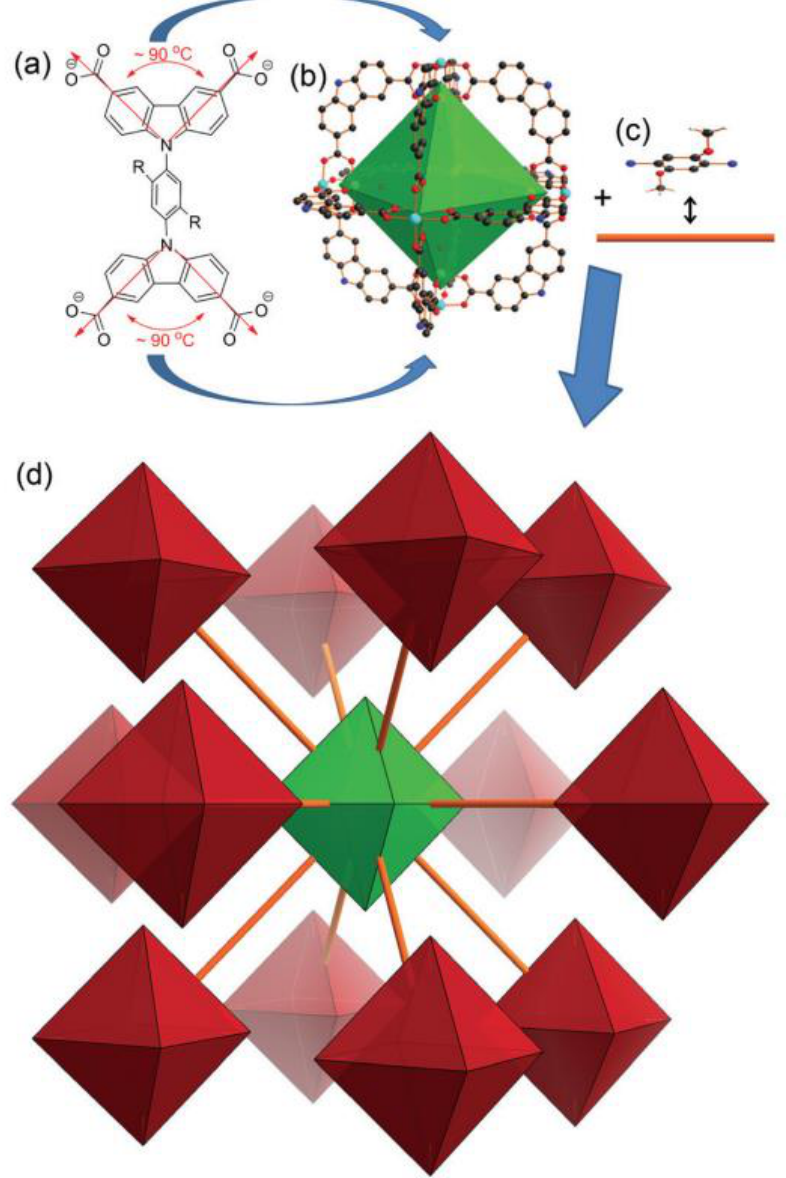
Figure 5. ( a ) pbcd and dpbcd linkers, ( b ) octahedral MOP, ( c ) phenyl linker between octahedral MOPs, ( d ) connectivity of octahedral MOPs in PCN-82 [79]. Adapted from ref. 81 with permission.